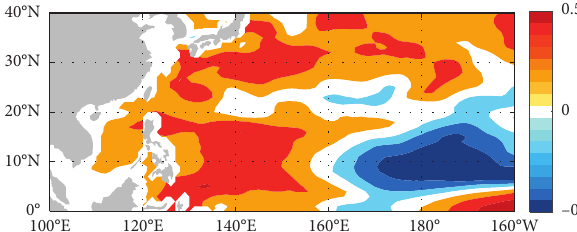
Figure 3: Distribution of correlation coefficient between JASON seasonal averaged SST and ocean subsurface